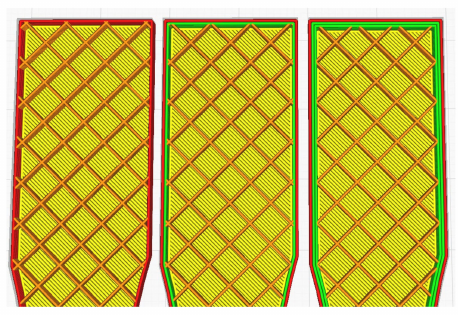
Figure 3. Wall perimeter: 1, 2 and 3 (left to right).